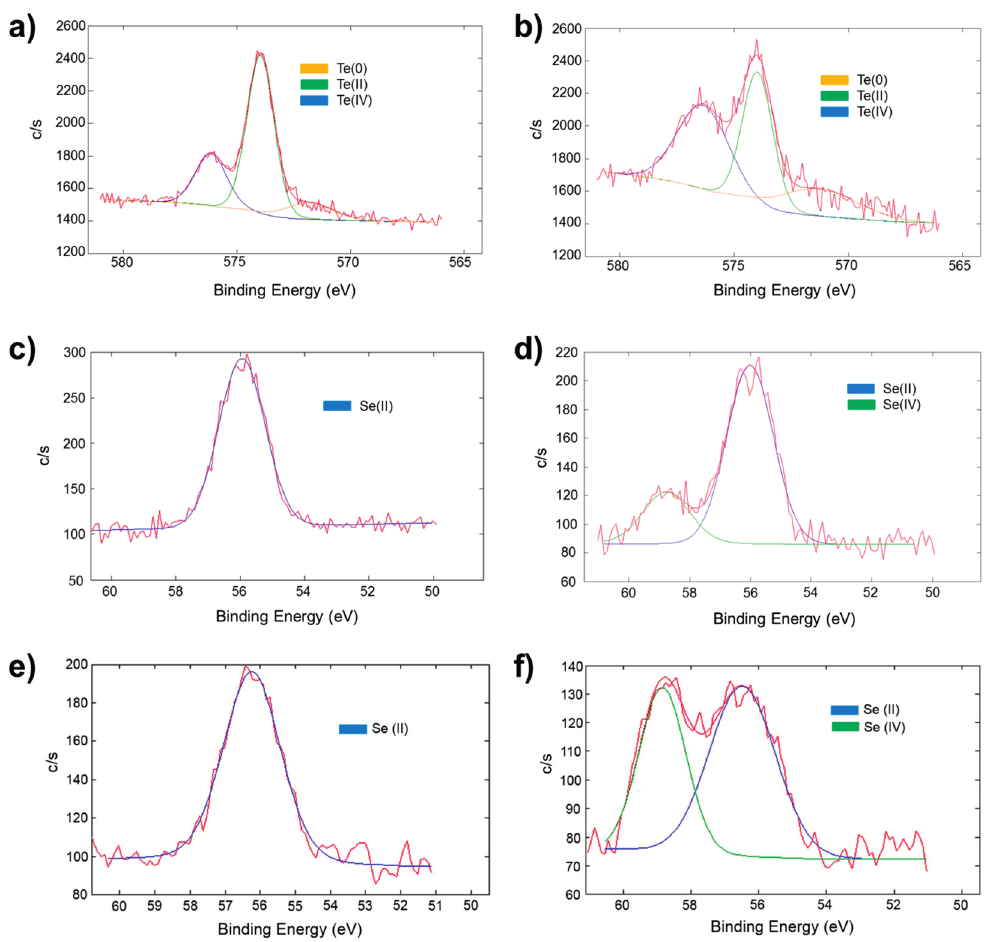
Figure 2. High resolution scans of ( a ) the Te 3d 5/2 peak region for the dry sample of TEOS-3 ; ( b ) the Te 3d 5/2 peak region for the TEOS-3 sample soaked in 1.0 × 10 − 4 M H 2 O 2 for 24 h; ( c ) the Se 3d peak region for the dry sample of TEOS-7 ; and ( d ) the Se 3d peak region for the TEOS-7 sample soaked in 1.0 × 10 − 4 M H 2 O 2 for 24 h; ( e ) the Se 3d peak region for the dry sample of TEOS-8 ; and ( f ) the Se 3d peak region for the TEOS-8 sample soaked in 5.0 × 10 − 5 M H 2 O 2 for 24